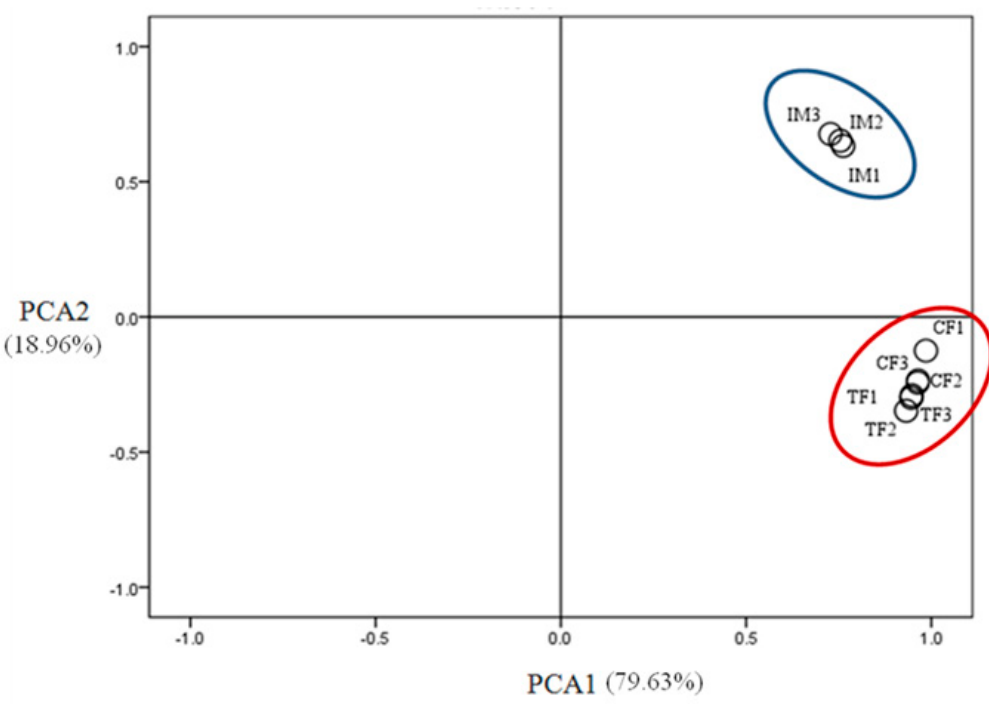
Figure 4. Clustering of control females (CF), high-temperature-treated females (TF), and high- temperature-induced neomales (IM) based on their gonadal transcriptome profiles by principal component analysis (PCA). Three individuals in CF and three individuals in TF formed a cluster (red circle), and three individuals in IM formed a distinct cluster (blue circle) on a PCA plot.